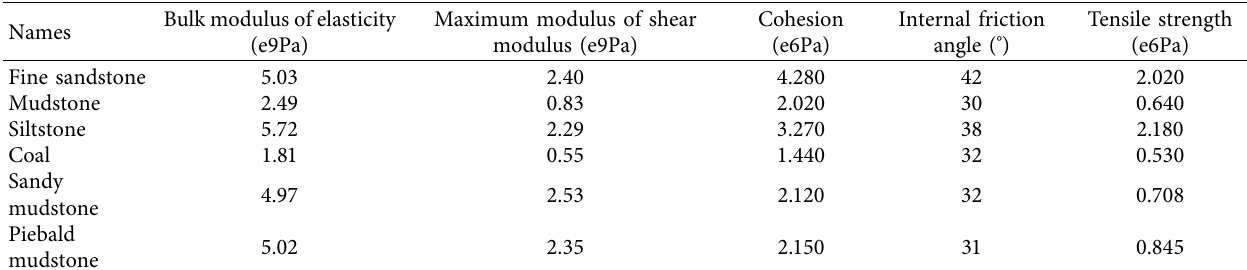
Table 1: Numerical simulation on mechanical parameters of rocks.